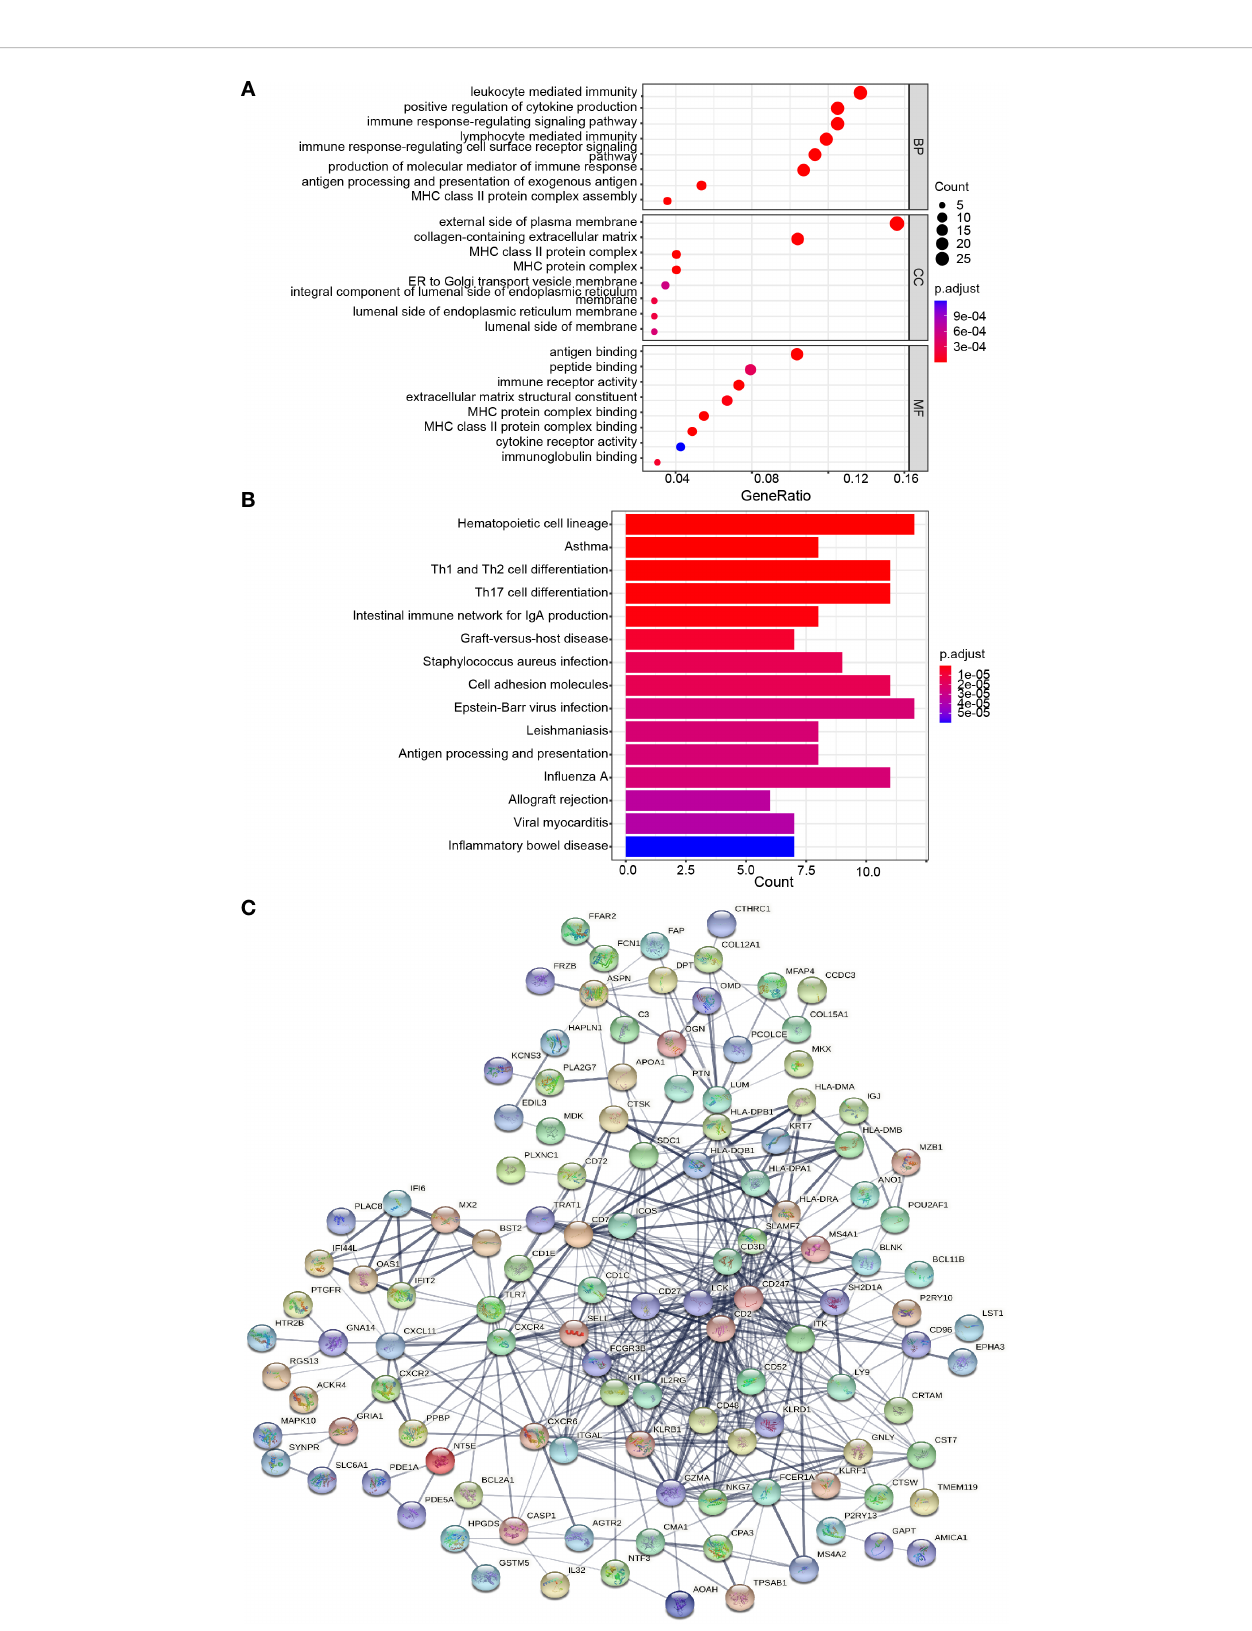
FIGURE 3 Protein-protein interaction (PPI) network and common DEGs enrichment analysis results. (A, B) The enrichment analysis results of GO and KEGG Pathway. Adjusted P -value < 0.05 was considered signi fi cant. (C) PPI network of the DEGs (score > 0.4) contained 170 nodes and 518 interaction